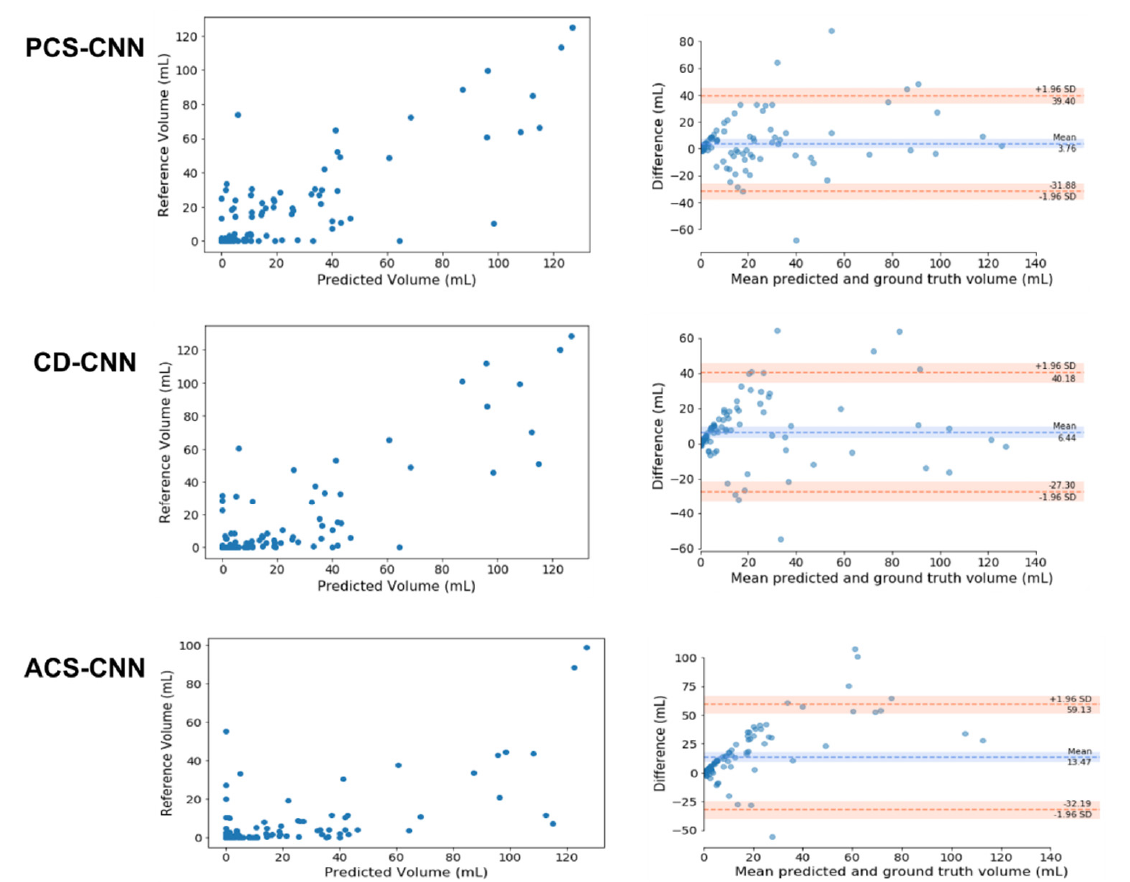
Figure 1. Comparison of the automated and reference segmentation volume for the Transfer Learned CNN (TL-CNN), Posterior Circulation Stroke CNN (PCS-CNN), Combined Datasets CNN (CD-CNN), and Anterior Circulation Stroke CNN (ACS-CNN). Left column: Scatter plots comparing lesion volumes derived from the reference segmentations ( y -axis) and from the automatic segmentations determined by the CNN ( x -axis). Right column: Bland–Altman plots of the lesion volumes. The volumes corresponding to the reference and automatic segmentations are shown on the x -axis and the volume difference is shown on the y -axis.